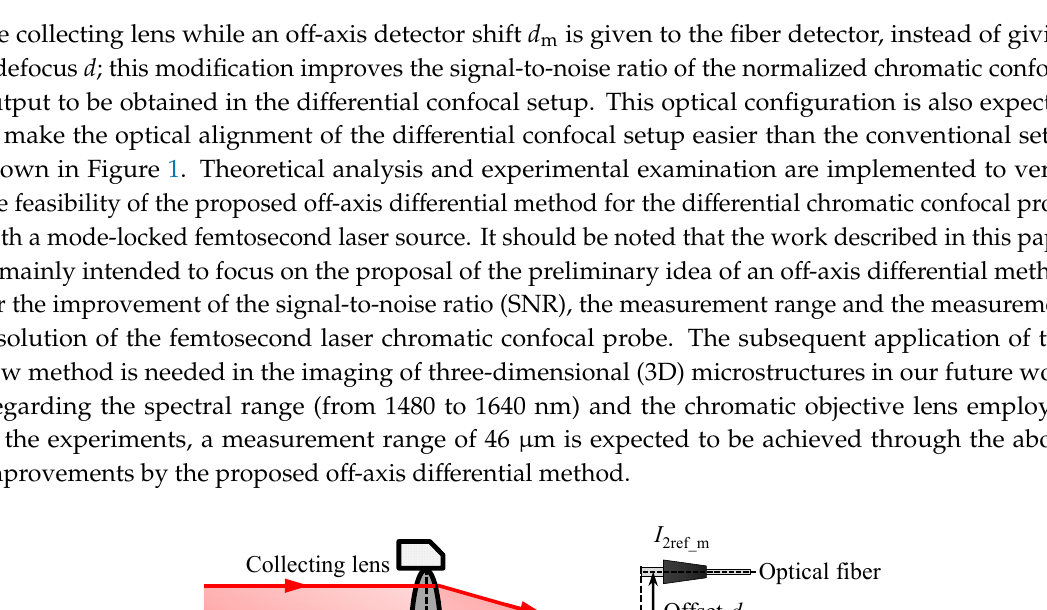
Figure 2. Reference detector unit with an off-axis detector shift d m in the newly proposed method.